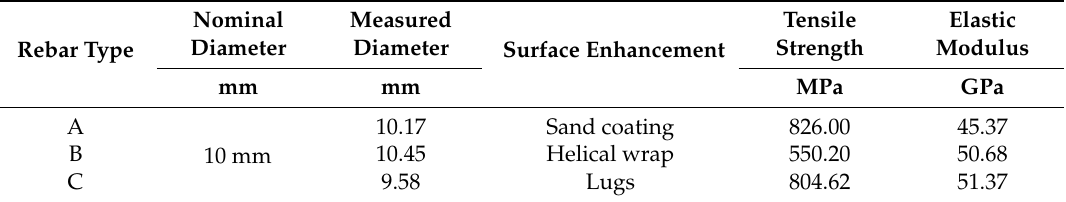
Table 1. Properties of the GFRP